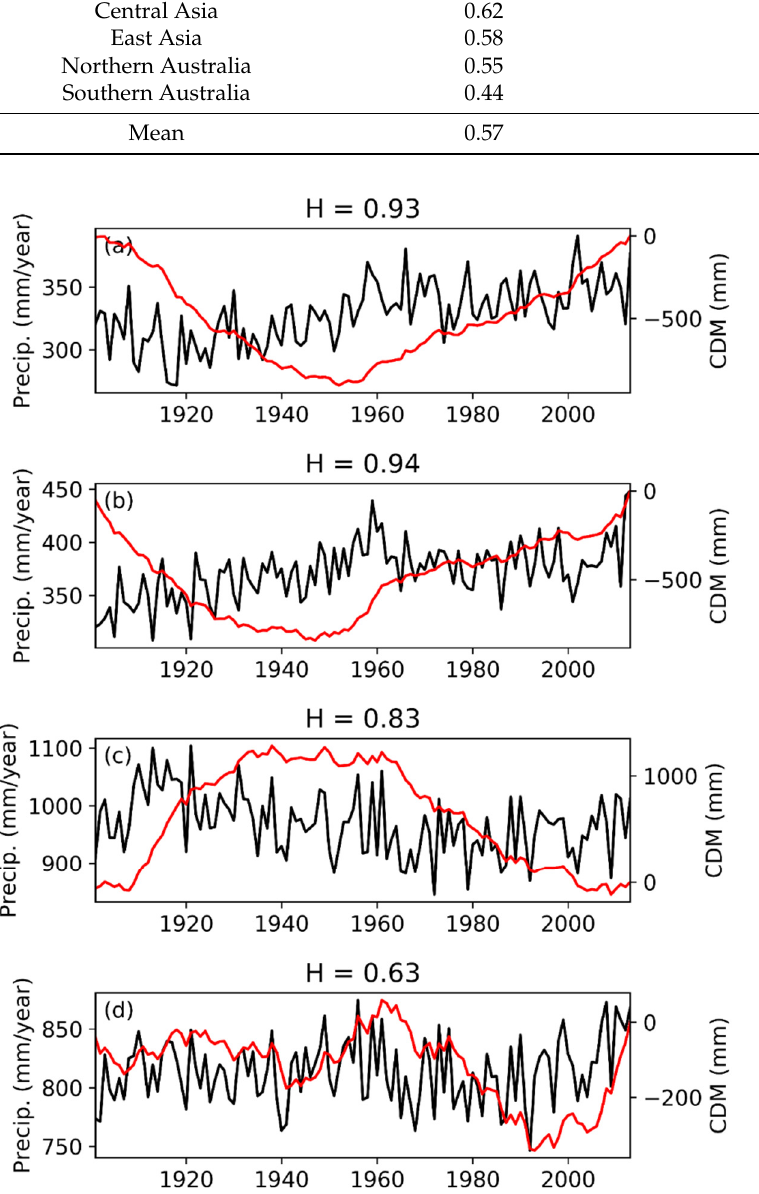
Figure 7. Time series and CDM plots for the three 40dd boxes (a–c), and the full Asian region (d).